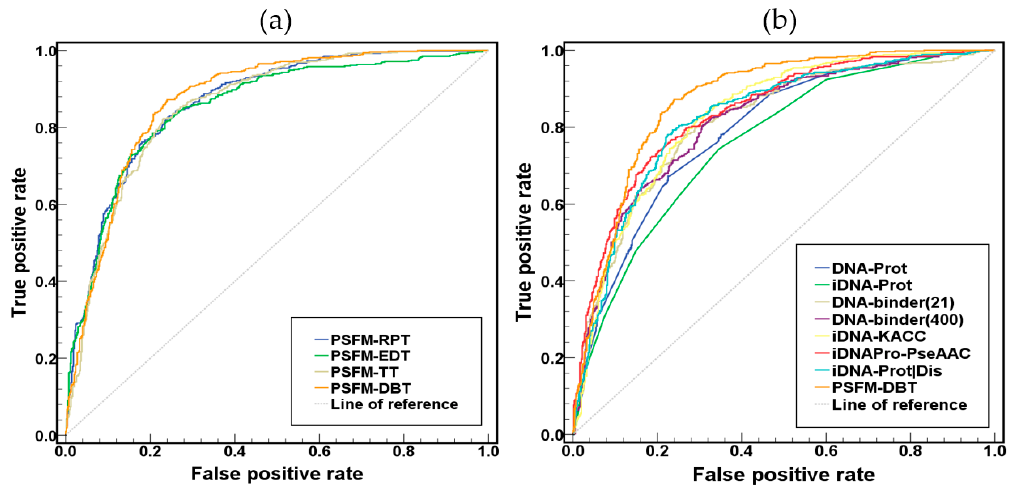
Figure 2. ( a ) The Receiver Operating Characteristic (ROC) curves of the four PSFM-based methods on the benchmark dataset using the jackknife tests. ( b ) The ROC curves of various methods on the benchmark dataset using the jackknife tests .